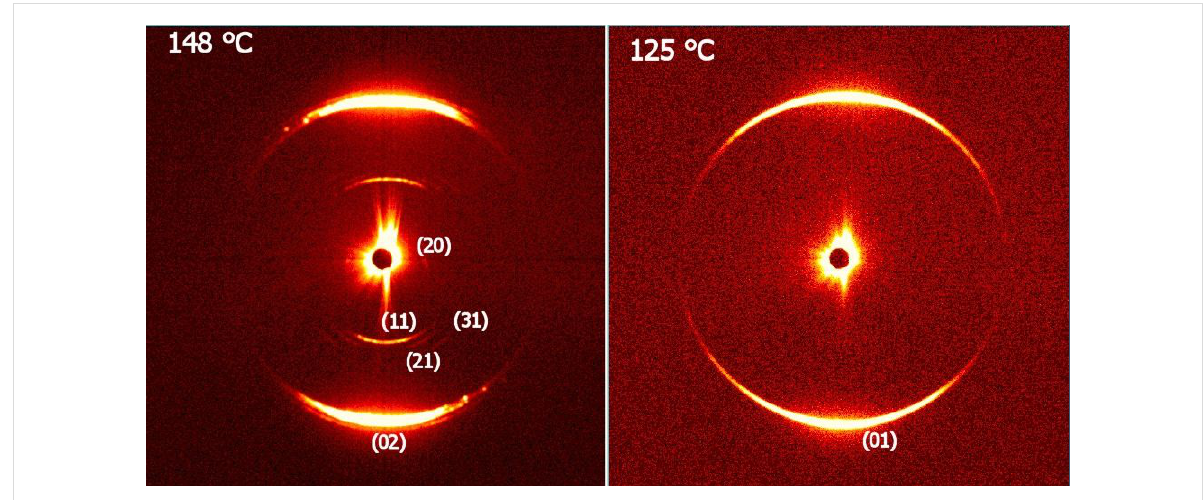
Figure 9: X-ray patterns of a partially aligned sample of IIb in (a) the SmC G phase at 148 °C and (b) in the SmC S P A phase at 125 °C. Signals in the SmC G phase were indexed assuming a rectangular unit cell with a = 362 Å and c = 90.8 Å.